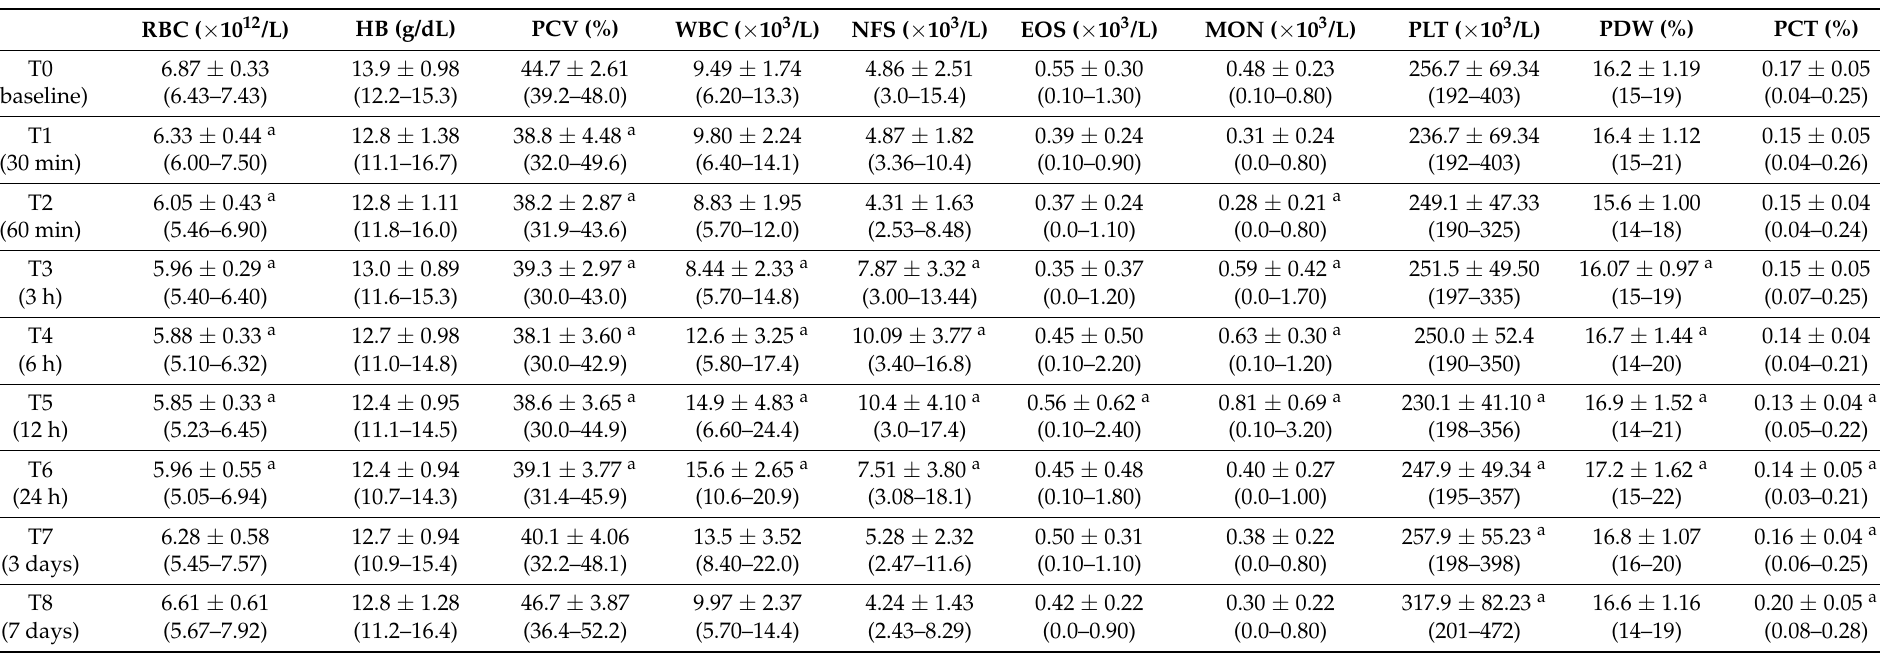
Table 1. Pre-, intra- and post-OHE mean ± SD of erythrocyte, leukocyte and platelets parameters in healthy bitches. Letter indicates significant differences vs. baseline values: a p <